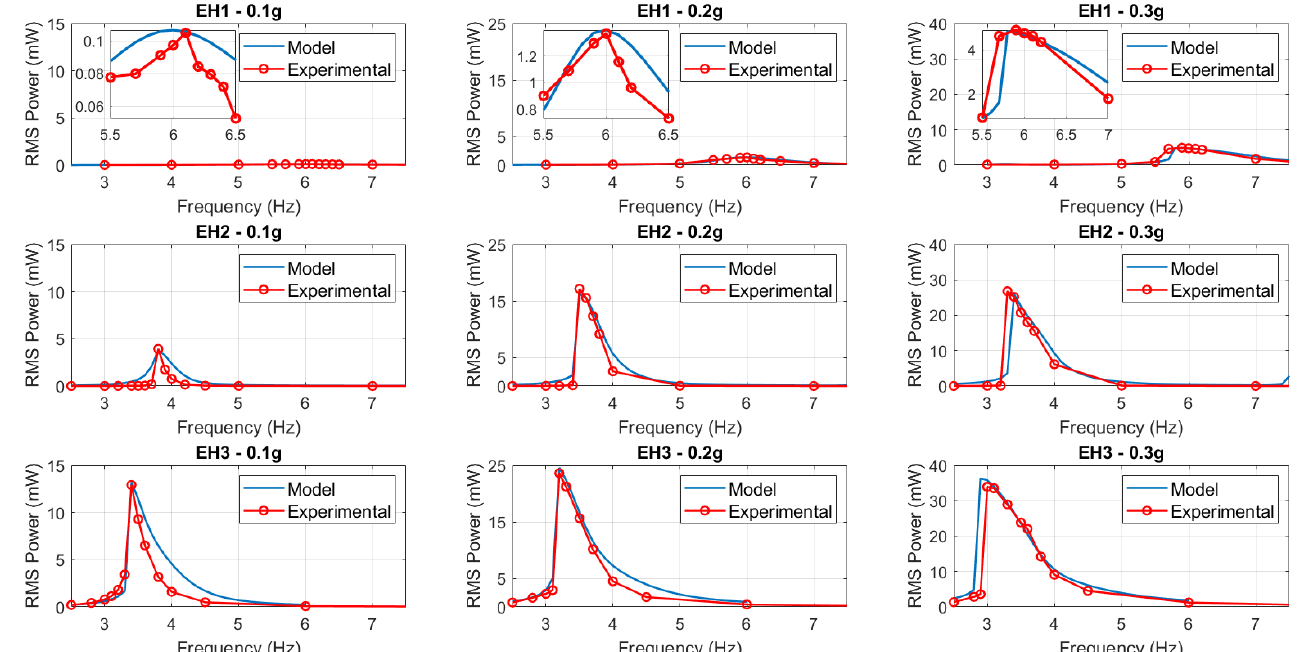
Figure 10. Experimental and model FRFs comparison for EH1, EH2, and